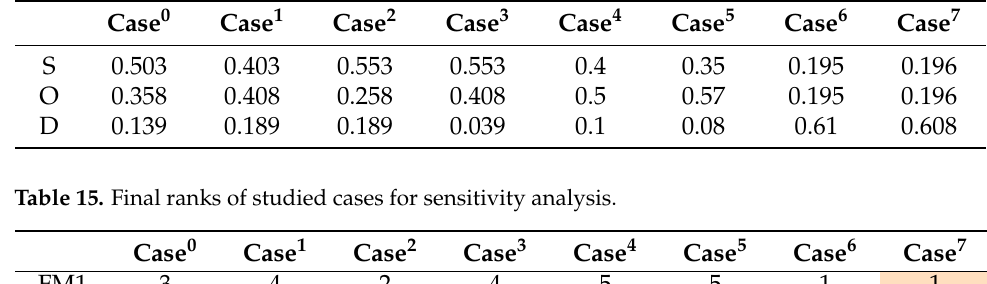
Table 14. Studied cases for sensitivity analysis.